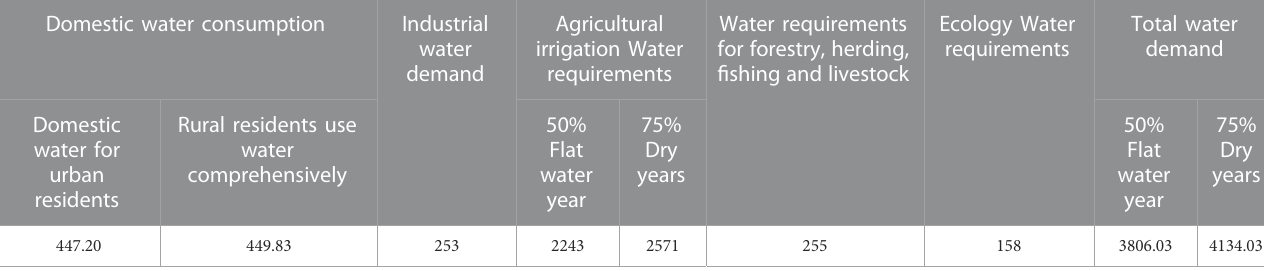
TABLE 8 Forecast results of water demand for chicheng county in the planning level year (2025).